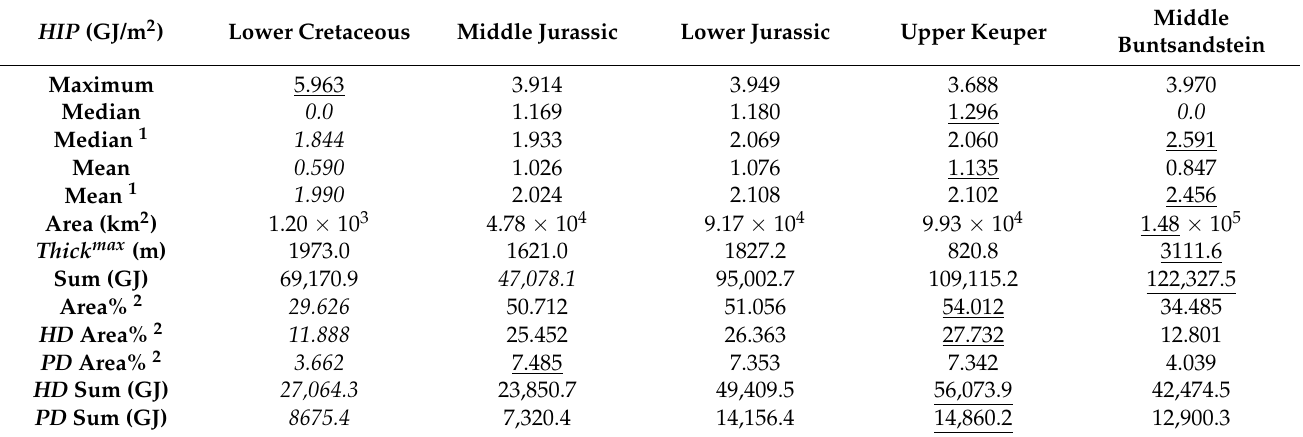
Table 3. Statistical HIP values of the reservoirs. 1 = Excluding areas of no potential, 2 = percent of total area with potential greater 0. Underlined values represent maximum and italics the minimum value of investigated units for the respective